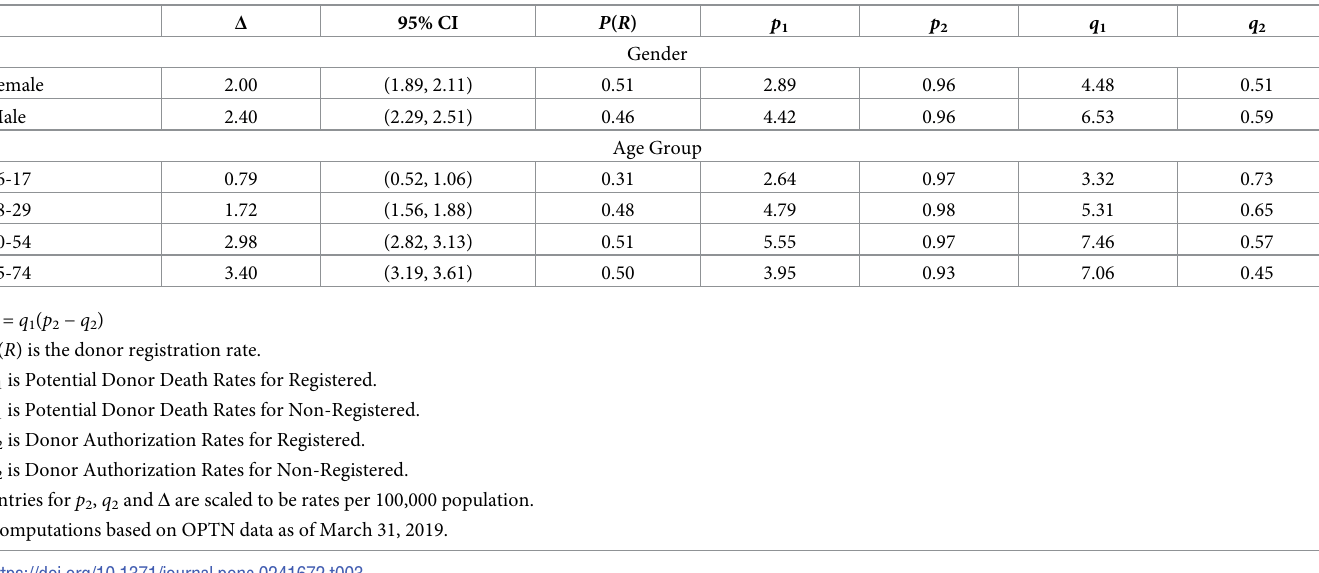
Table 3. 2018 estimates, gender and age.